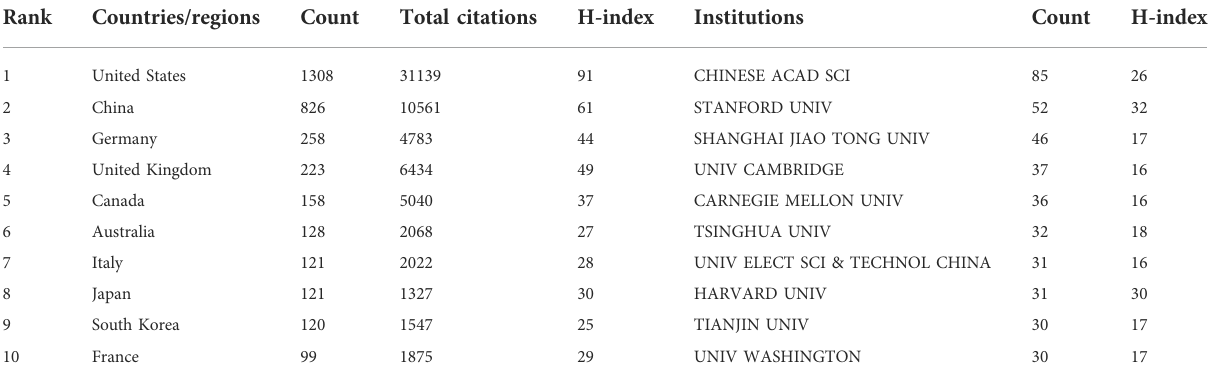
TABLE 1 Top 10 countries/regions and relevant institutions. Rank Countries/regions